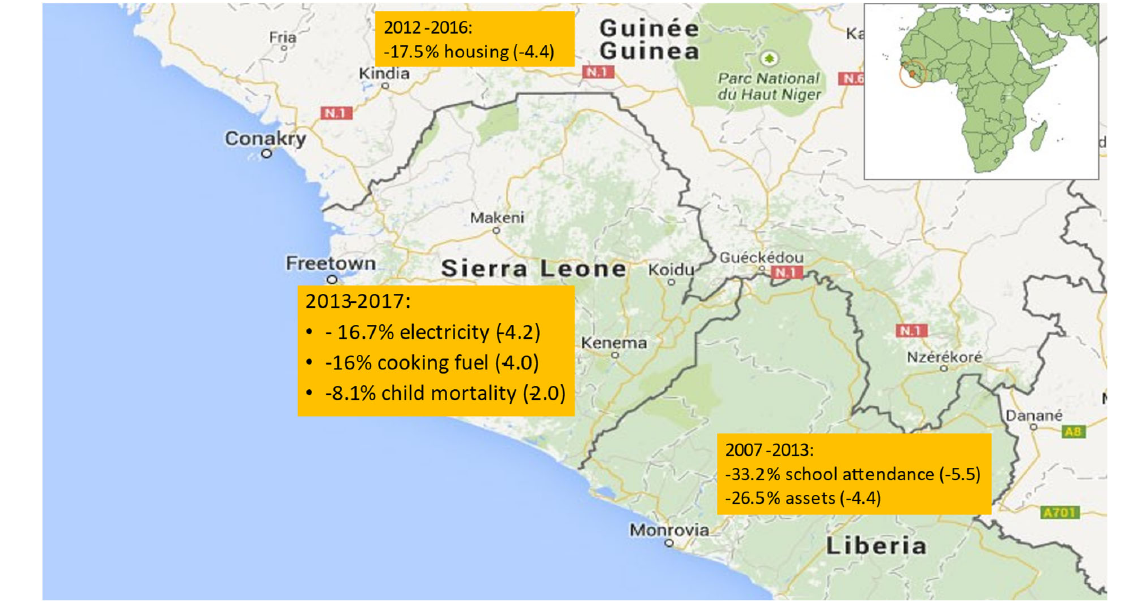
Figure 1. Countries and indictors of poverty reduction where each country ranked first among developing countries analized by UNDP & OPHI (2020) [15]. Percentage change between surveys years and annuliazed change in parenthesis.